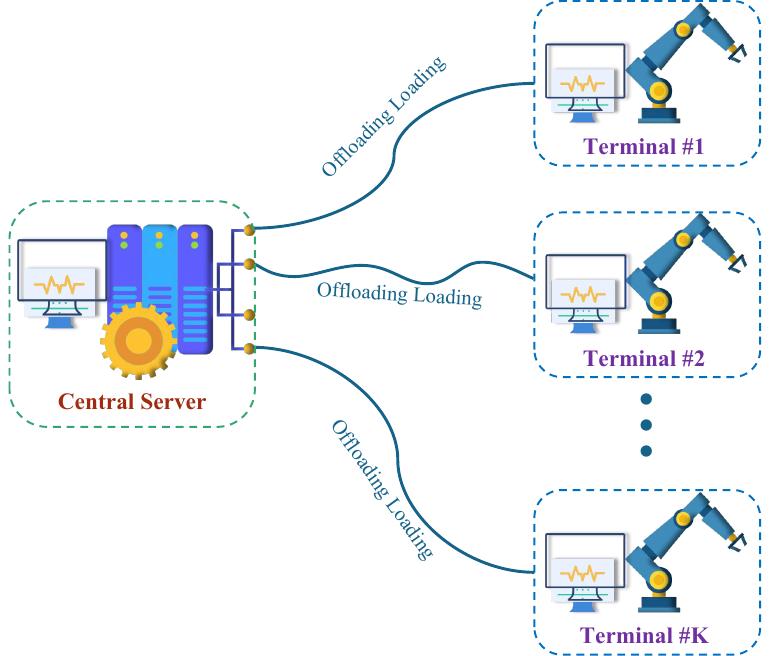
Figure 1. The framework of the conventional mechanical fault diagnosis system in which the terminal uploads the monitoring data to a central server through the network cable for